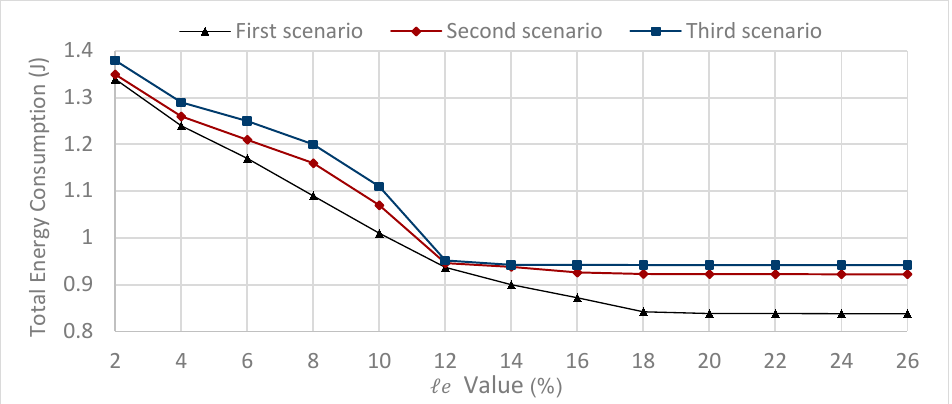
Figure 3. Impact of (cid:96) e parameter on the total energy consumption varying number of nodes for the first scenario, the second scenario and the third scenario.